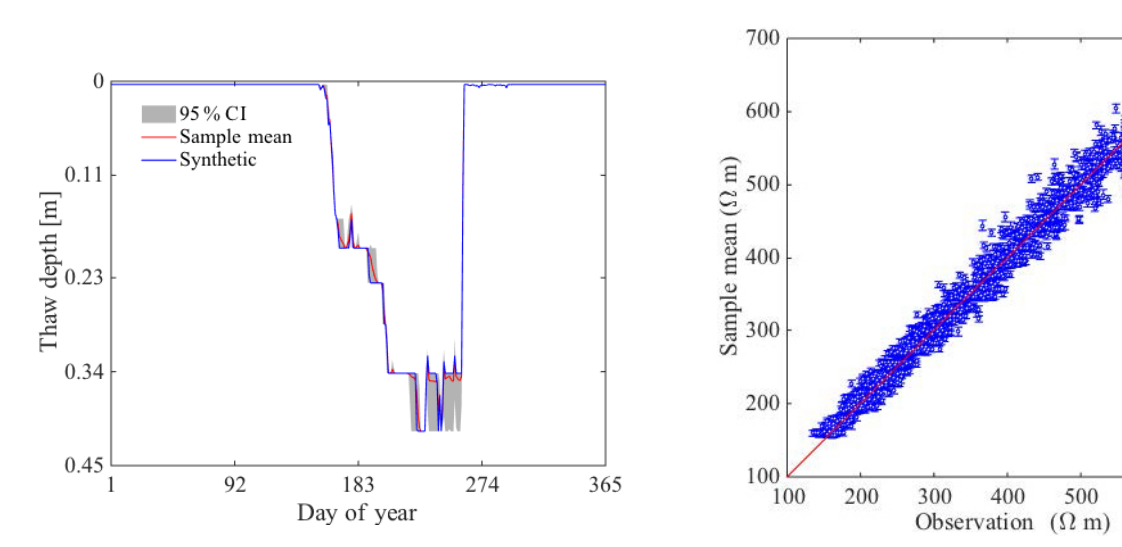
Figure 14. Comparison between “observation” and predicted ap- parent resistivity. The red line denotes the 1:1 line. The vertical error bar on the blue symbols represents the confidence interval of the predicted apparent resistivity with a confidence level of 95%. The comparison was based on a posteriori samples of scenario